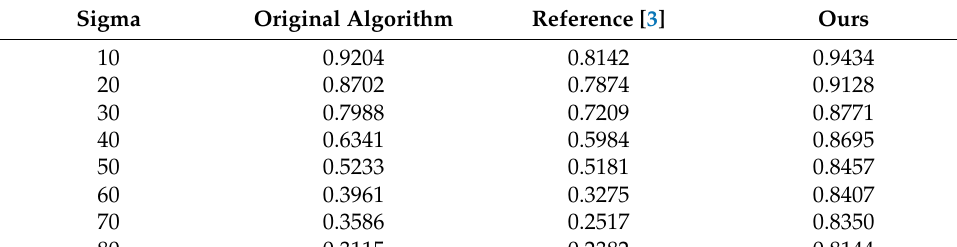
Table 3. Structural similarity index metric (SIM) of the three algorithms for the Cameraman image.